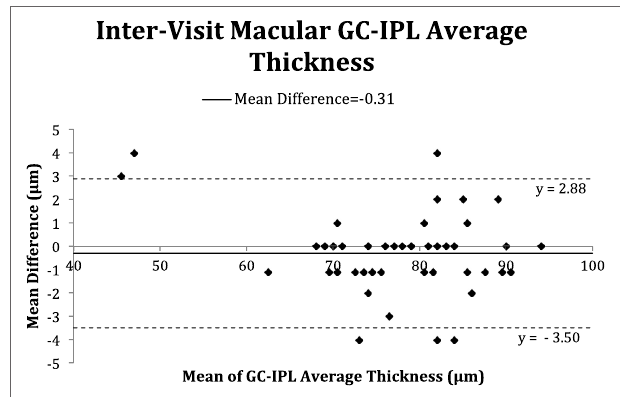
FigUre 5 | Bland–Altman plot of inter-visit macular ganglion cell-inner plexiform layer (GC-IPL) average thickness.